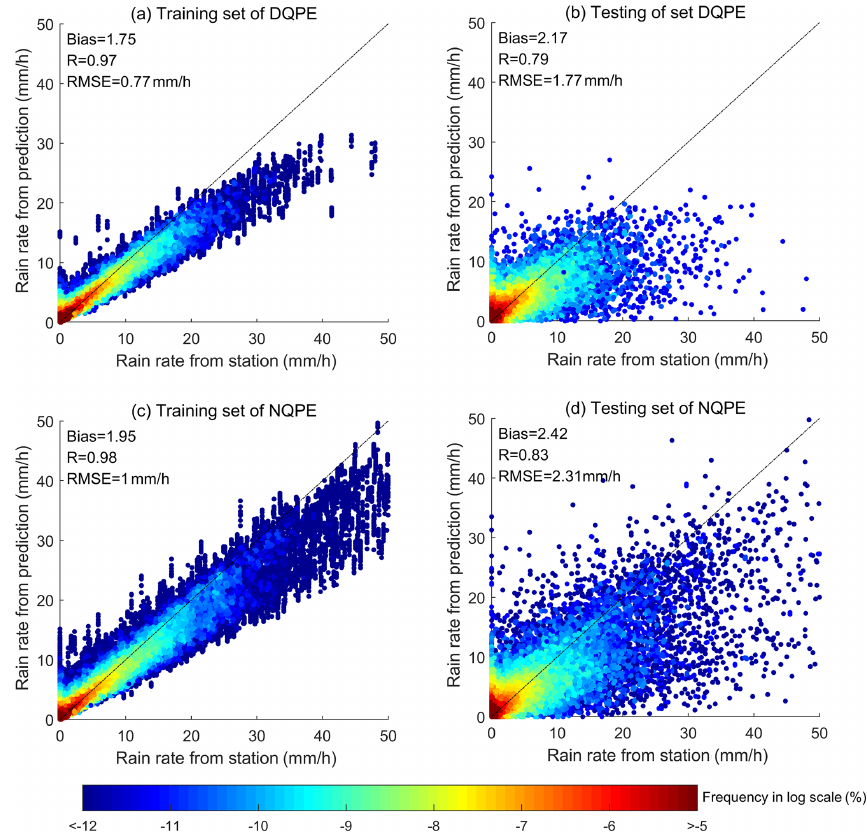
Figure 4. Comparison of the precipitation measured by high-density automatic stations and that estimated by the QPE algorithm: (a) training set of DQPE; (b) testing set of DQPE; (c) training set of NQPE; (d) testing set of NQPE. Colour bar: occurrence frequency (on a log scale) at intervals of 0.5mmh − 1 . Table 3. Evaluation metrics in training set and testing set of DQPE (NQPE) algorithm. Model